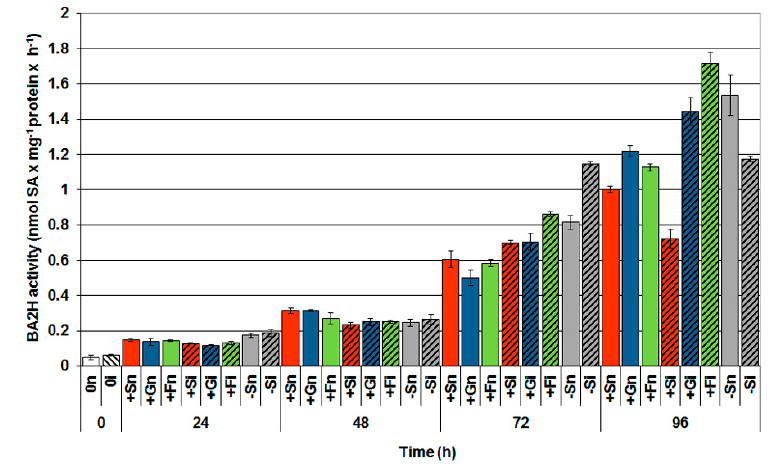
Figure 6. E ff ect of sucrose, glucose and fructose on the activity of benzoic acid 2-hydroxylase (BA2H) in in vitro cultured embryo axes of Lupinus luteus infected with Fusarium oxysporum f. sp. lupini . A summary of the statistical significance of di ff erences between the average values of each pair at p < 0.05 can be found in the Supplementary Files (Table